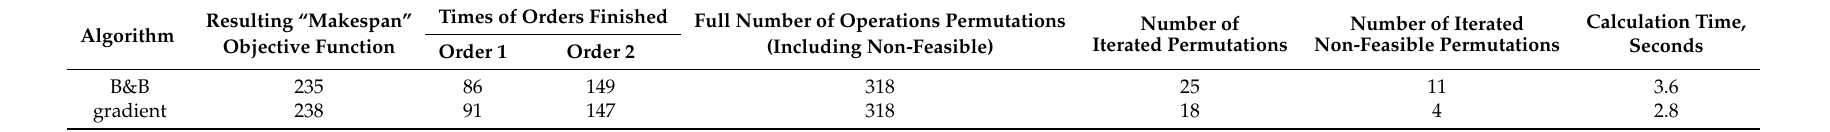
Table 1. Algorithms test results: small number of operations (13 operations).